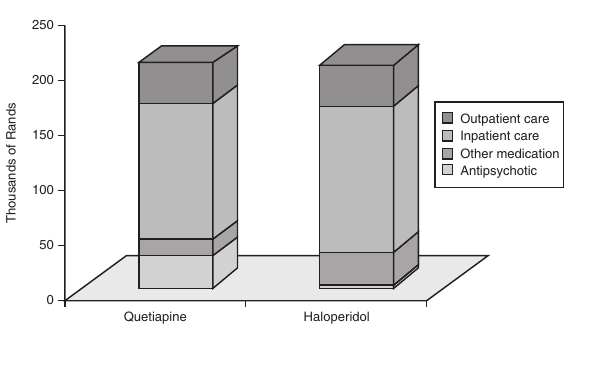
Fig. 2. Total estimated direct costs per patient treated in the public sector in South